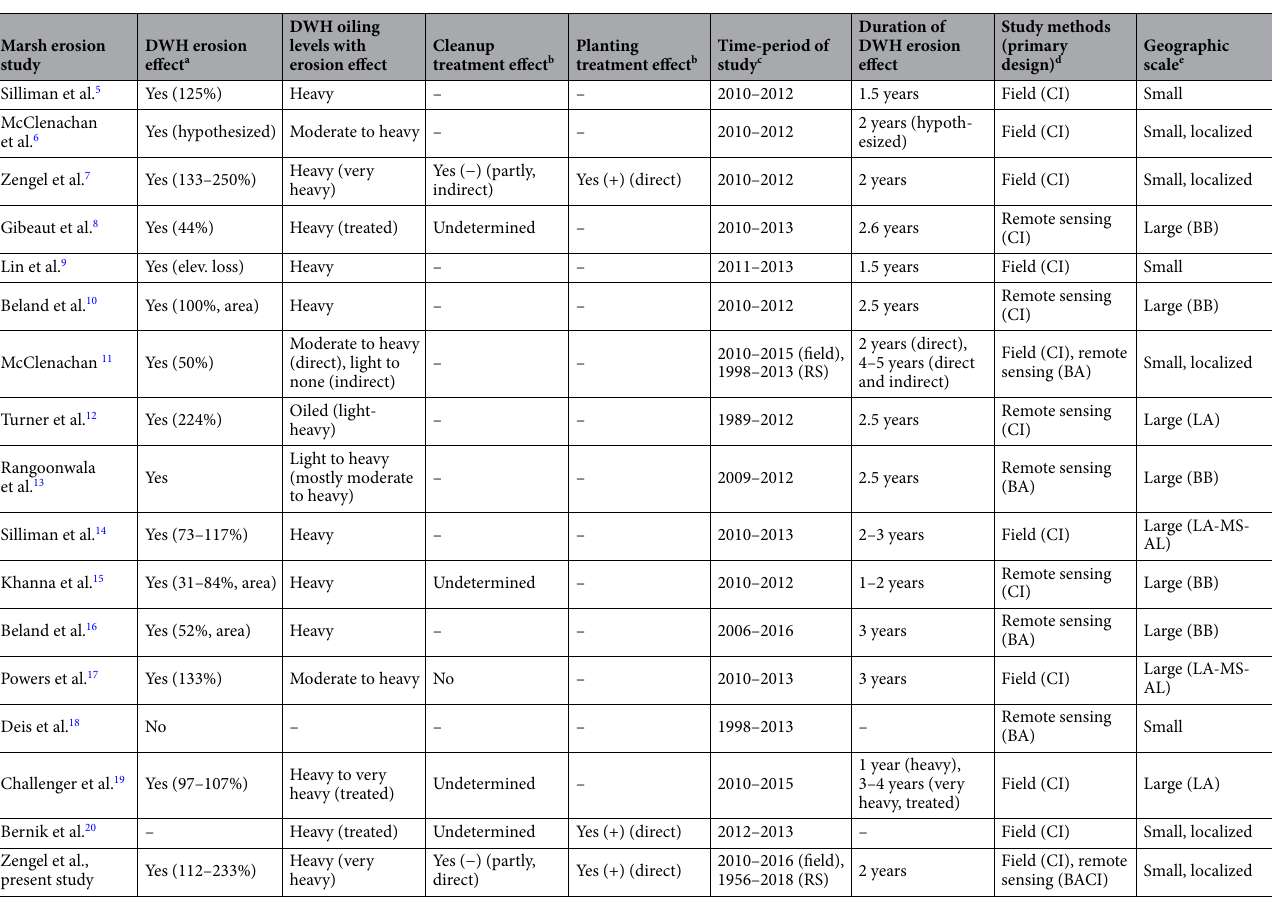
Table 1. Summary of Deepwater Horizon oil spill (DWH) marsh erosion studies to date. a Percent increase in linear erosion rate in parentheses unless otherwise noted. b Positive (+) or negative (−) effects indicated, undetermined = studies that included treated marsh but without direct comparisons to untreated sites with similar oiling levels or with inconclusive results. c RS remote sensing. d CI control-impact, BA before–after,